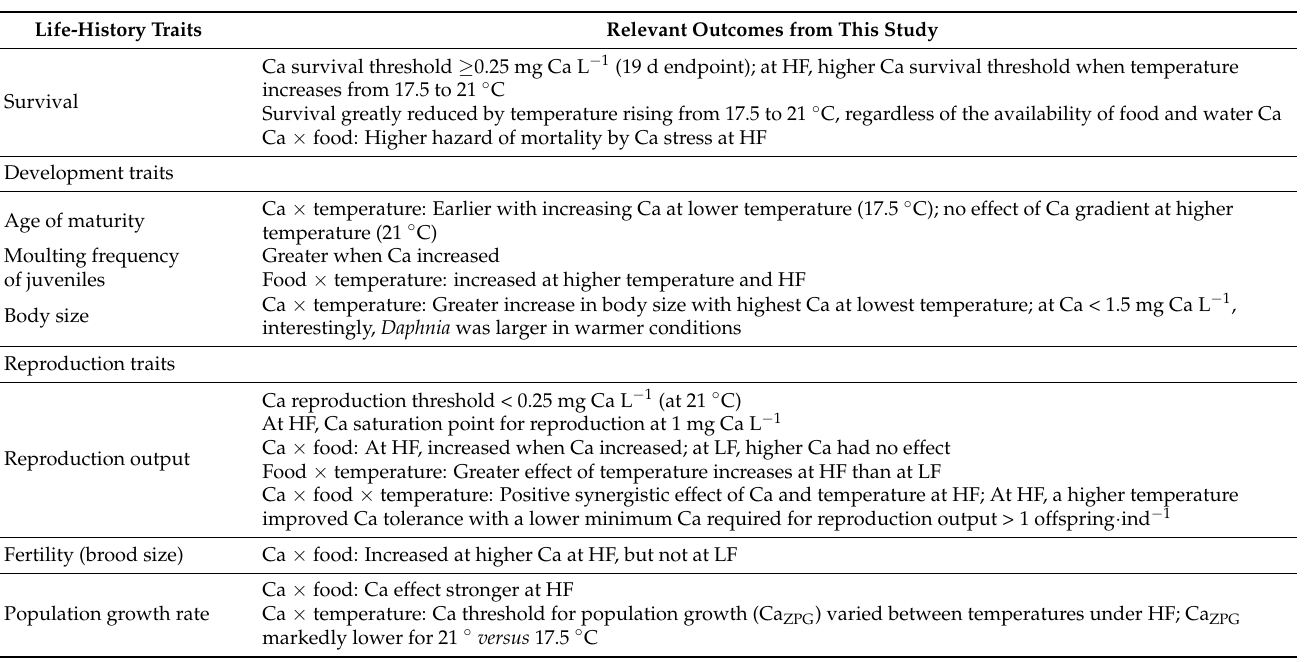
Table 4. Summary of combined effects of water Ca, food quantity, and temperature on life-history traits and population fitness of D. pulex.